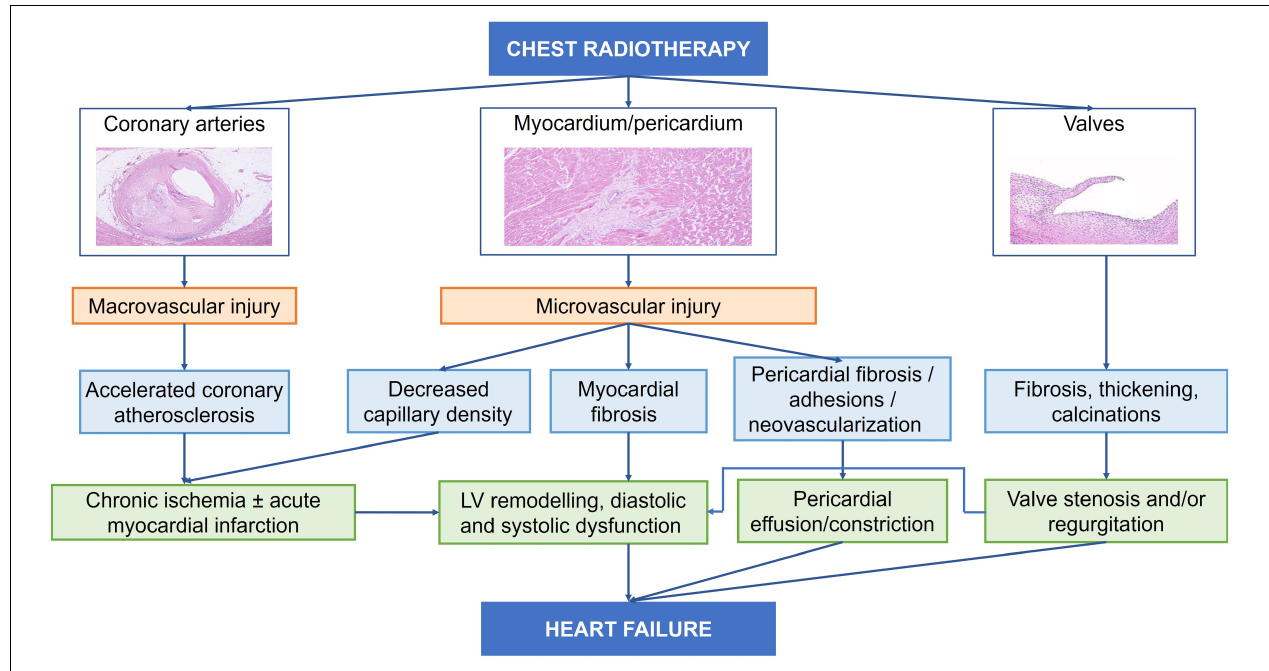
FIGURE 2 | Pathophysiology of radiotherapy-induced